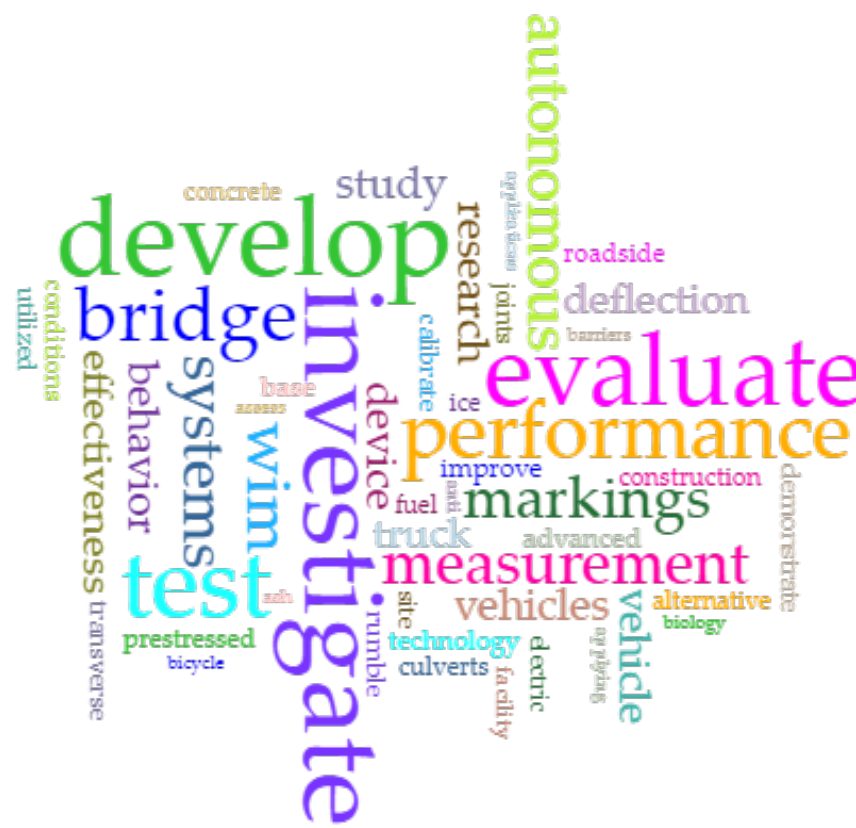
Figure 9. Word cloud describing non-pavement application terms using APT.